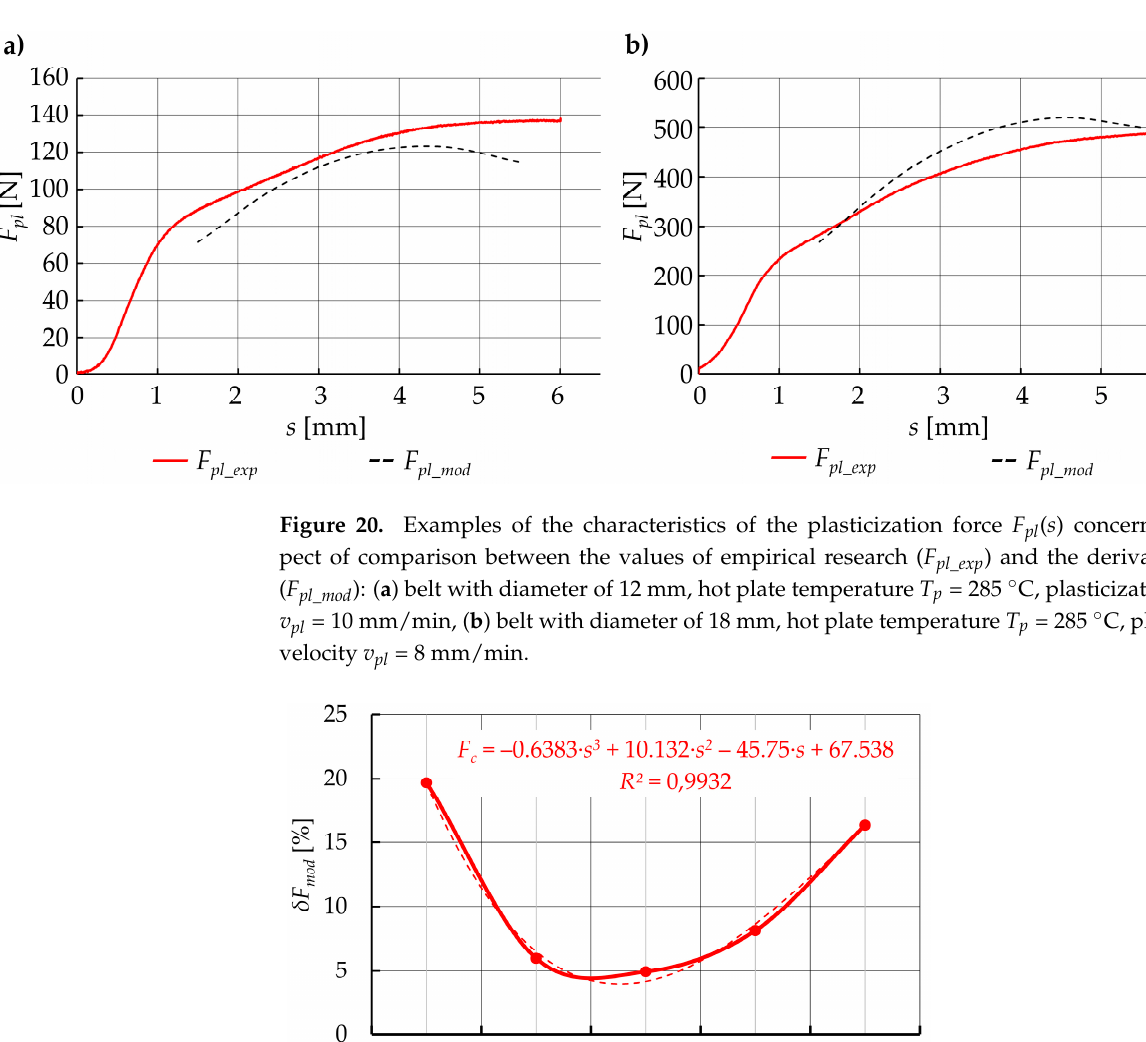
Figure 21. Exemplary correction function that describes the absolute error between the experimental plasticization force F pl_exp and calculated model F pl_mod for the belt with diameter of 12 mm, plasticized with velocity v pl = 10 mm/min, and with the hot plate temperature T p = 285 °C.